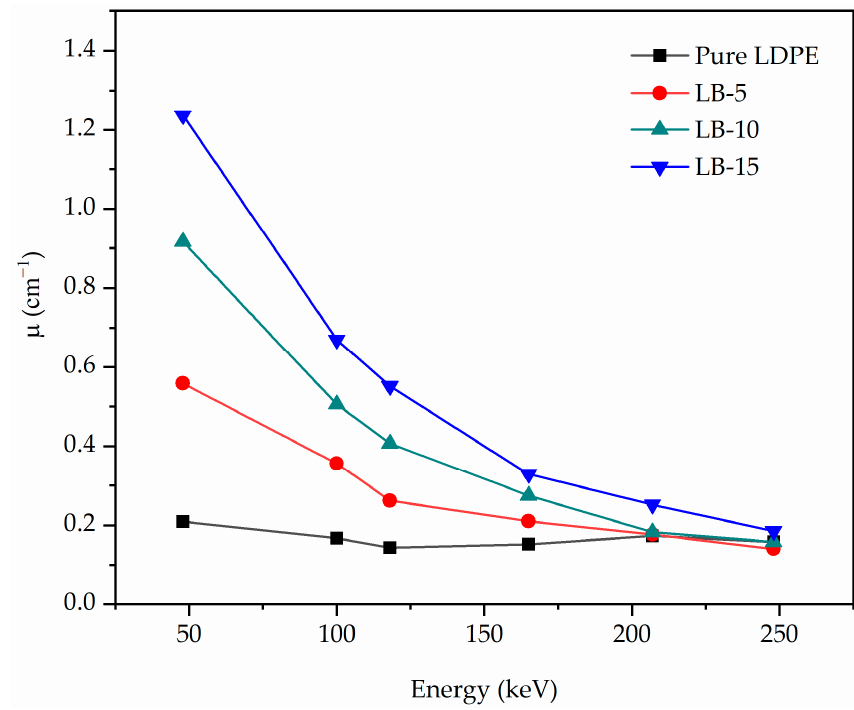
Figure 7. The measured linear attenuation coefficient against incident beam energy .